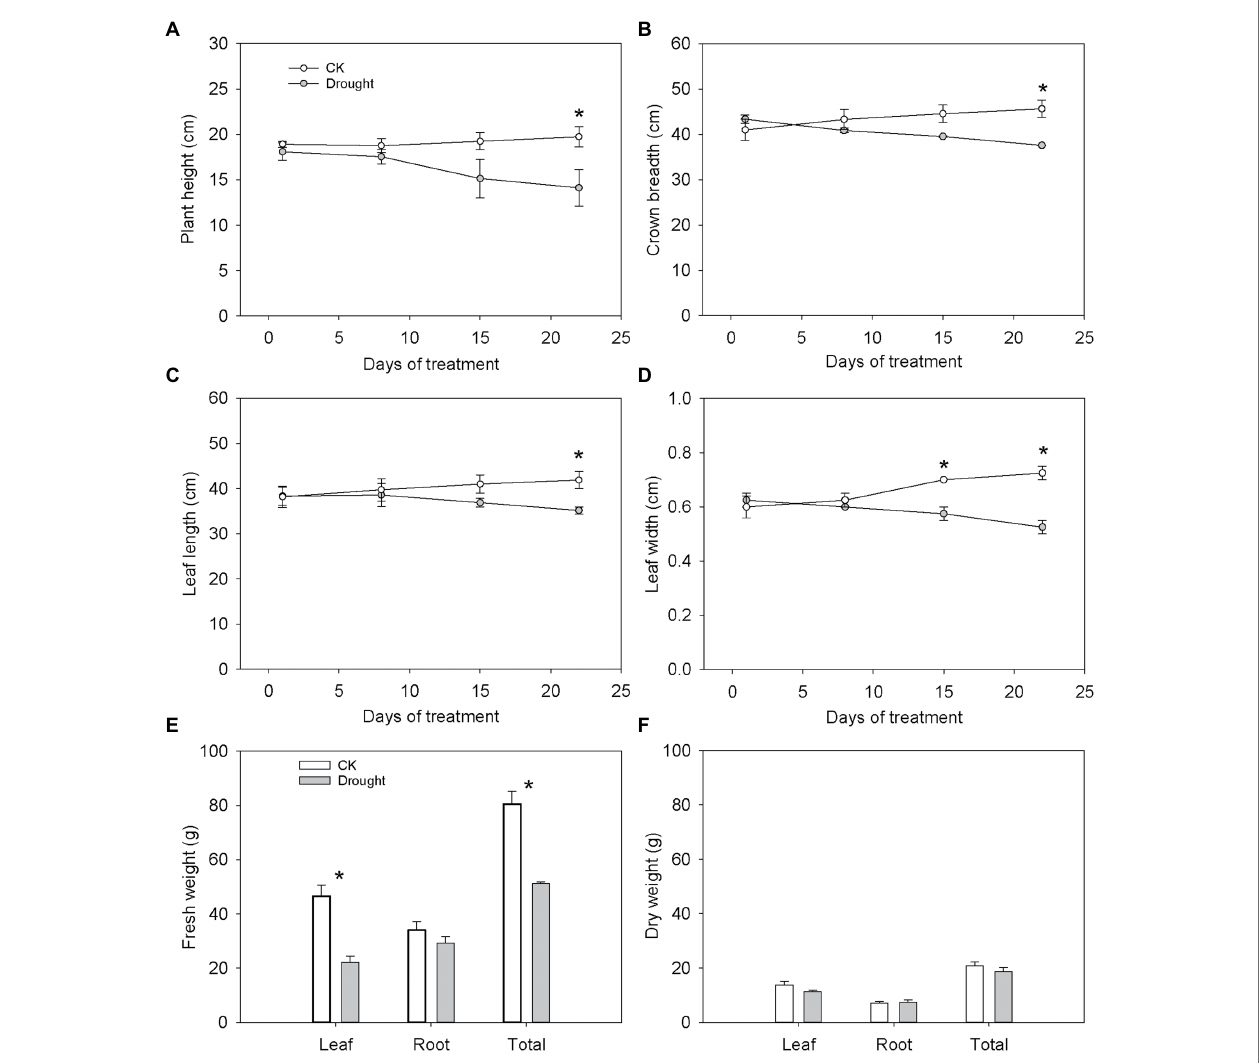
FIGURE 1 | Growth characters of Carex breviculmis . (A) Plant height. (B) Crown breadth. (C) Leaf length. (D) Leaf width. (E) Fresh weight. (F) Dry weight. Asterisk (*) denotes a significant difference at p < 0.05. Vertical bars indicate standard error ( n =